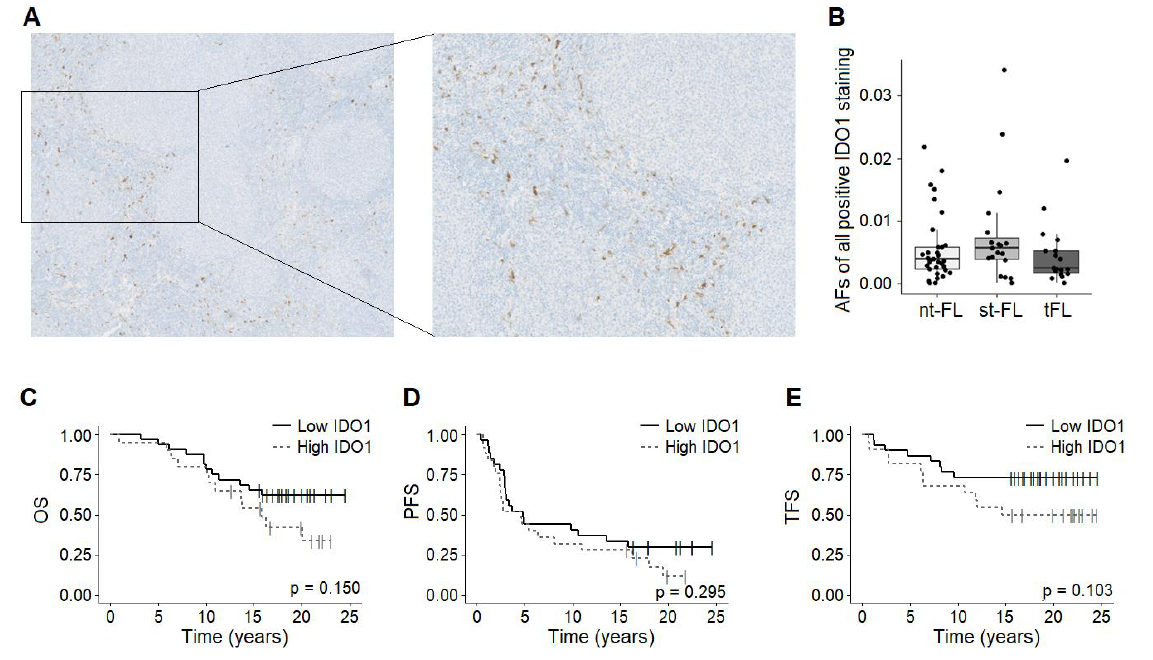
Figure 1. Intratumoral expression of IDO1 in FL. ( A ) Representative images of immunohistochemical staining of IDO1 in diagnostic nt-FL biopsies. Left: magnification of × 5, right: magnification of × 10. ( B ) Boxplot showing AFs of IDO1 in nt-FL, st-FL, and tFL samples, respectively. ( C – E ) Kaplan–Meier curves showing survival stratified according to IDO1 status and OS, PFS, and TFS, respectively. AF, area fraction; IDO1, indoleamine 2,3-dioxygenase 1; nt-FL, non-transforming FL; OS, overall survival; PFS, progression-free survival; st-FL, subsequently transforming FL; tFL, transformed FL; TFS, transformation-free